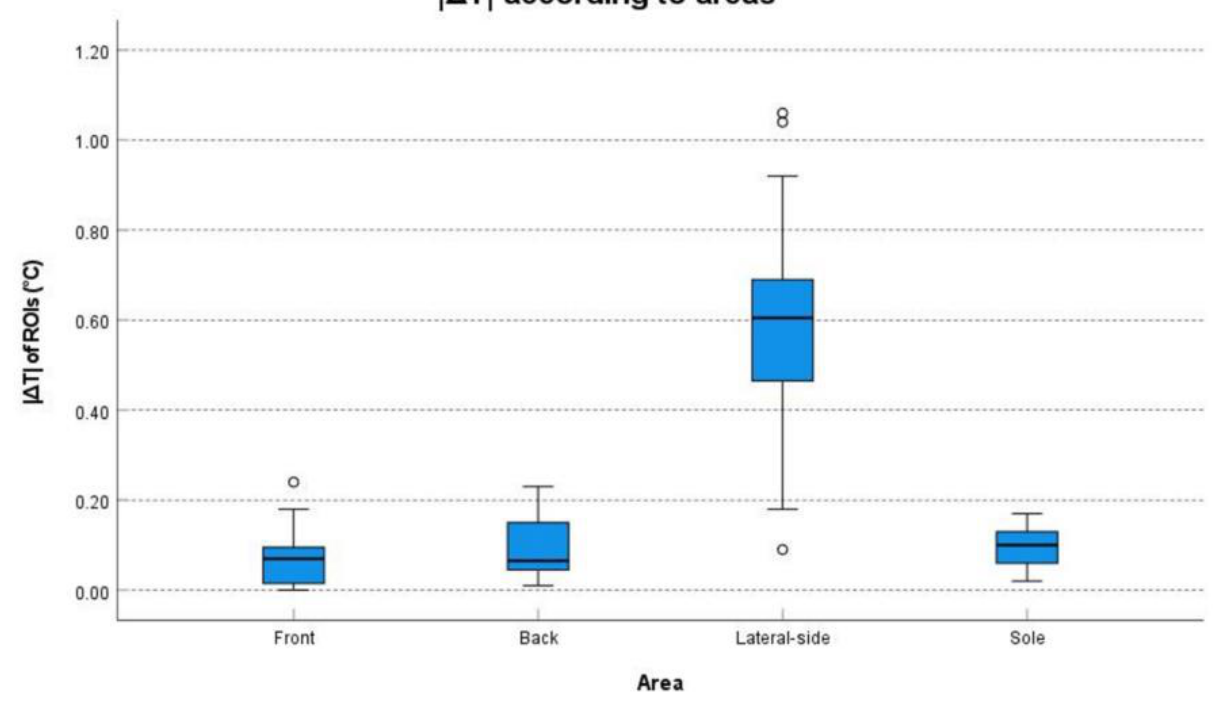
Figure 2. Diagram of the mean temperature according to the four areas. ROIs: region of interests; and * and ⸰ are labels that are out of range.